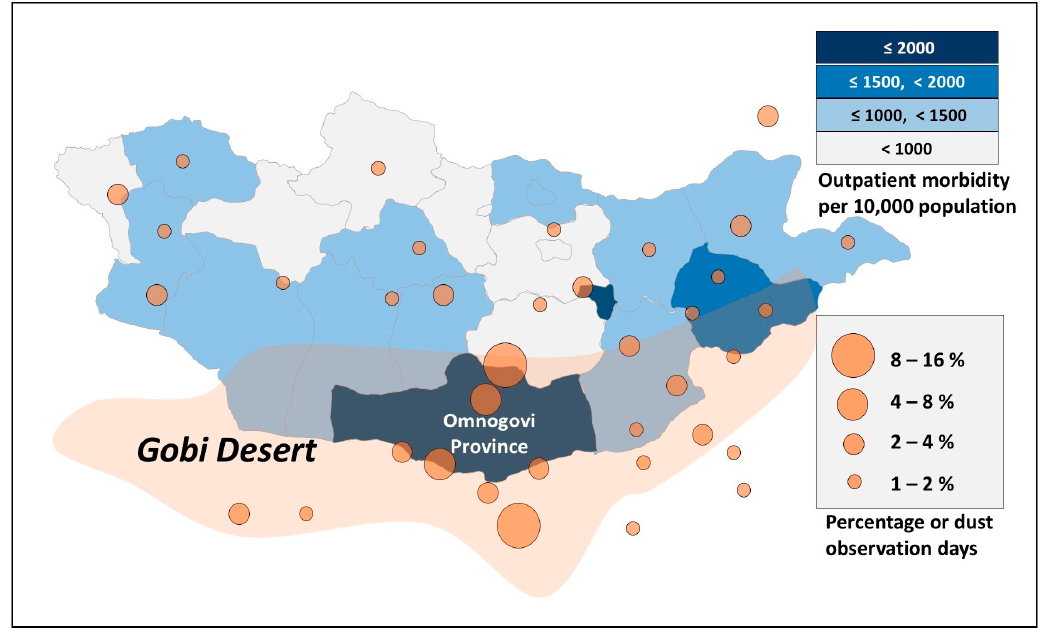
Figure 2. Morbidity associated with diseases of the respiratory system in each province of Mongolia (2011) and observations of dust event (1988–2004). Dust days were based on Code Table 4677 of the World Meteorological Organization (WMO) and dust outbreak frequency was defined as the percentage of the number of dust outbreaks to the total number of observations. The elements of surface meteorological data were the 3-hourly present weather and the surface wind speed at a height of 10 m in East Asia from March 1988 to May 2004 from WMO (see detail in Reference [3]). This dust outbreak map is a modified version of Figure 3 in Reference